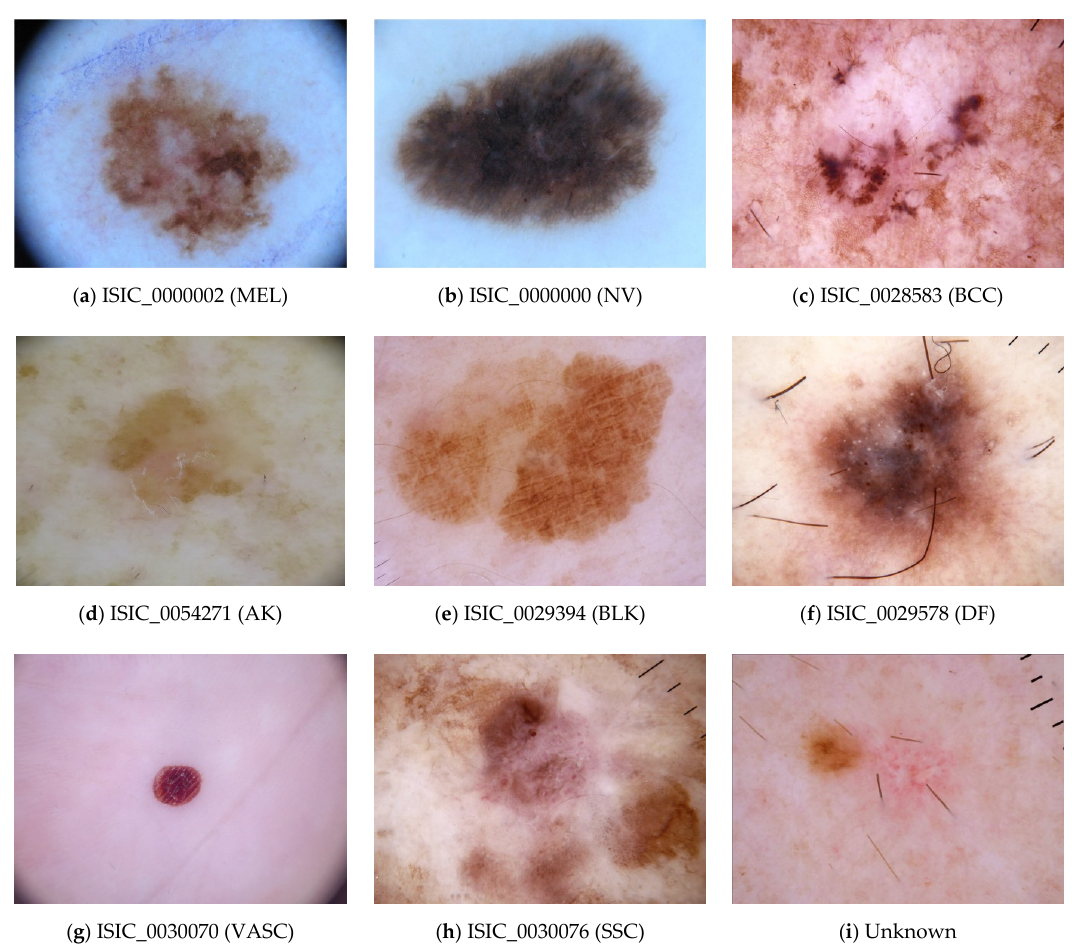
Figure 5. ISIC Skin Disease dataset. ( a ) Melanoma (MEL), ( b ) Melanocytic nevus class category (NV), ( c ) Basal cell carcinoma (BCC), ( d ) Actinic keratosis (AK) ( e ) Benign keratosis (BKL) ( f ) Dermatofibroma (DF) ( g ) Vascular lesion (VASC) ( h ) Squamous cell carcinoma (SSC) ( i ) Unknow Disease.